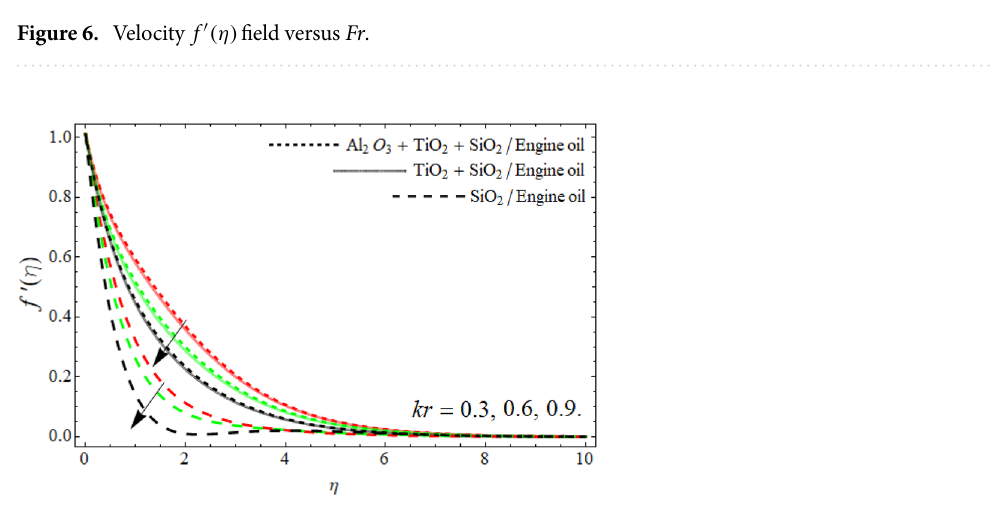
Figure 7. Velocity f ′ (η) field versus porosity term kr .